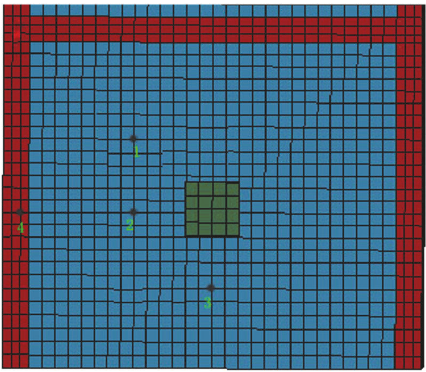
Figure 6: Locations of nodes in the impacted transverse